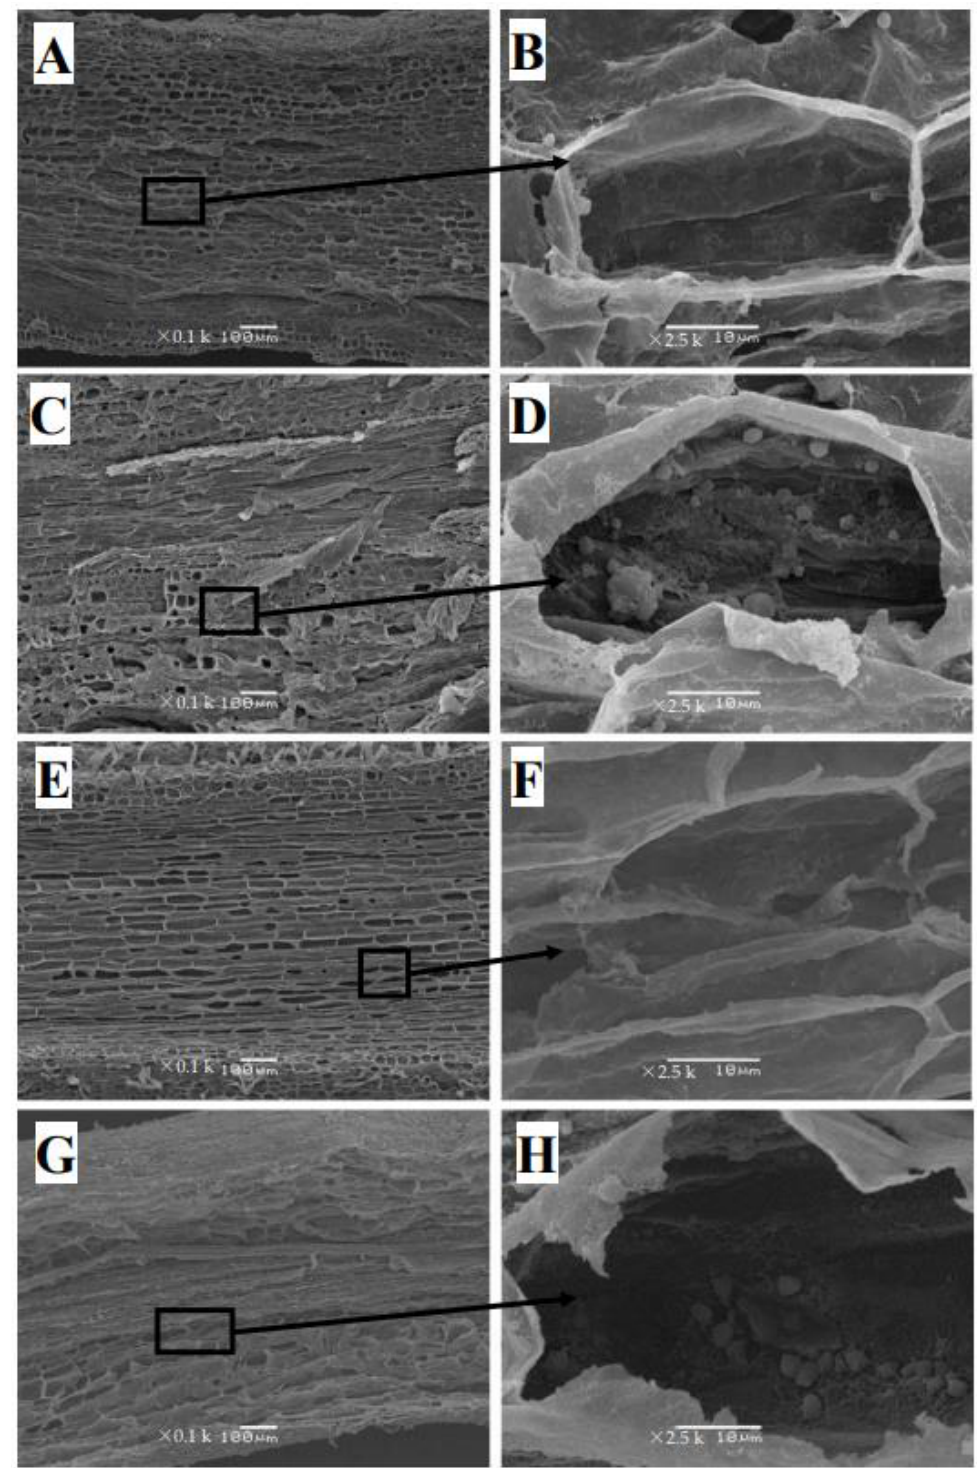
Figure 3. The SEM images of the longitudinal section of 0.5 µM ( A , B , E , F ) and 300 µM Cu-treated ( C , D , G , H ) roots of two citrus species. C. sinensis : ( A – D ); C. grandis : ( E – H ). The right figures are partial enlargements of the left figures. The granules in cells labeled by arrows are starch granules. The scales in figures ( A , C , E , G ) represent 100 μm. The scales in figures ( B , D , F , H ) represent 10 μm.